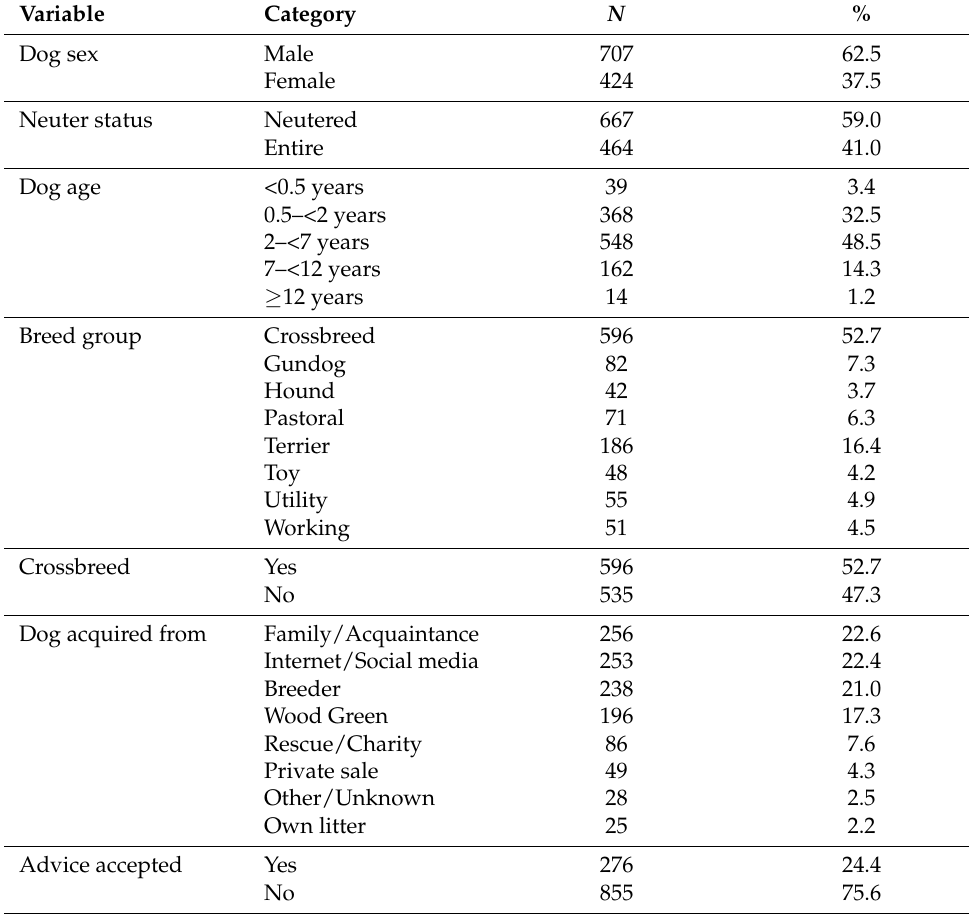
Table 1. Descriptive statistics of calls received by Wood Green relating to behaviour-based dog relinquishment requests between January 2017 and August